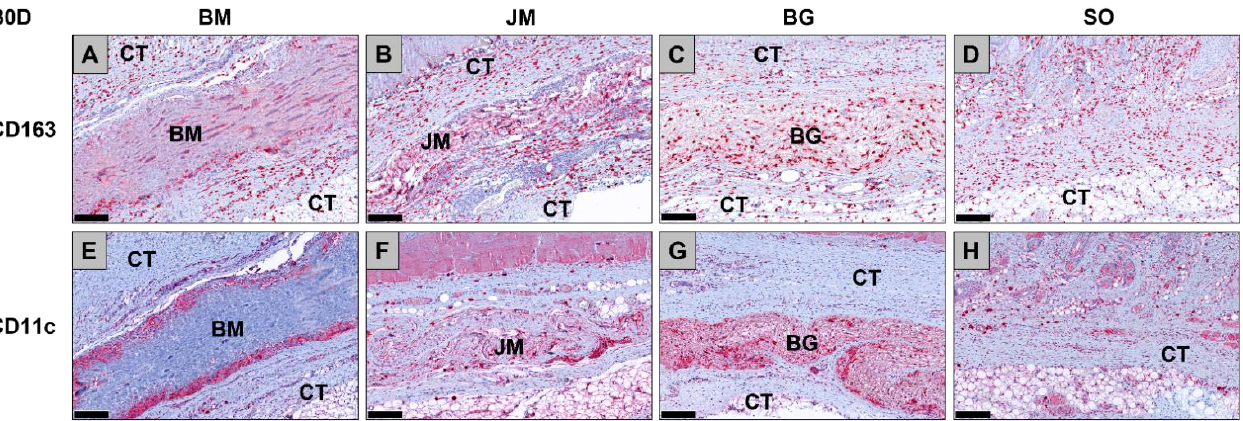
Figure 7. Exemplary histological images of the distribution of anti-inflammatory CD163-positive macrophages ( A – D ) and pro-inflammatory CD11c-positive macrophages ( E – H ) (red staining) within the implant beds of the three membranes within the subcutaneous connective tissue (CT) at day 30 post implantationem. ( A ) BM = Bovine membrane, ( B ) JM = Jason ® membrane, ( C ) BG = Bio-Gide ® membrane, ( D ) Sham operation group without biomaterial insertion (CD163-immunostainings ( A – D ) and CD11c-immunostainings ( E – H ), 200× magnifications, scalebars = 200 µm).